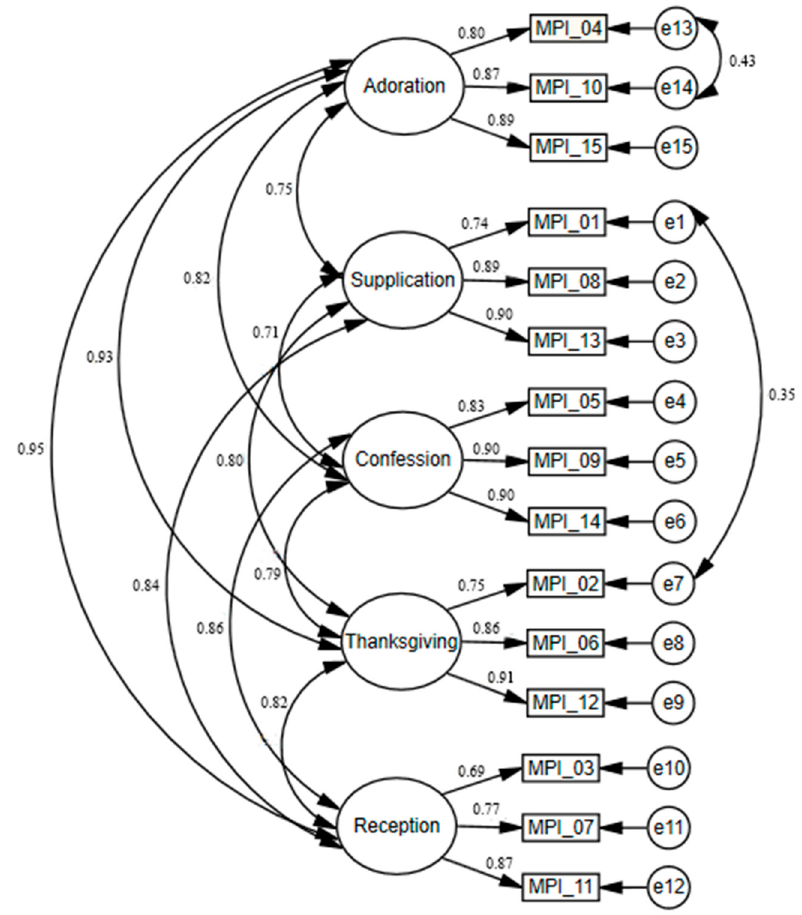
Figure 1. Confirmatory Factor Analysis of the Multidimensional Prayer Inventory: χ 2 (78) = 228.20, p < 0.001, χ 2 / df = 2.92, TLI = 0.957, CFI = 0.968, NFI = 0.953, SRMR = 0.030, and RMSEA = 0.074. Afterwards, we tested gender Measurement Invariance (MI) in the five-factor model.